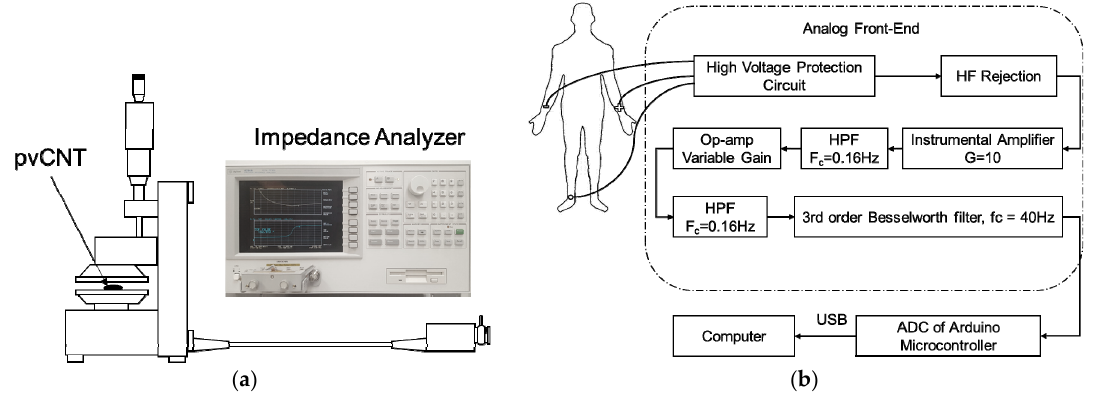
Figure 3. ( a ) Impedance measurement setup using Fixture 16451B attached to the Agilent 4294A Impedance Analyzer. ( b ) The block diagram of the AFE of the OLIMEX shield that are connected to the Arduino board and then to the computer through a USB cable.